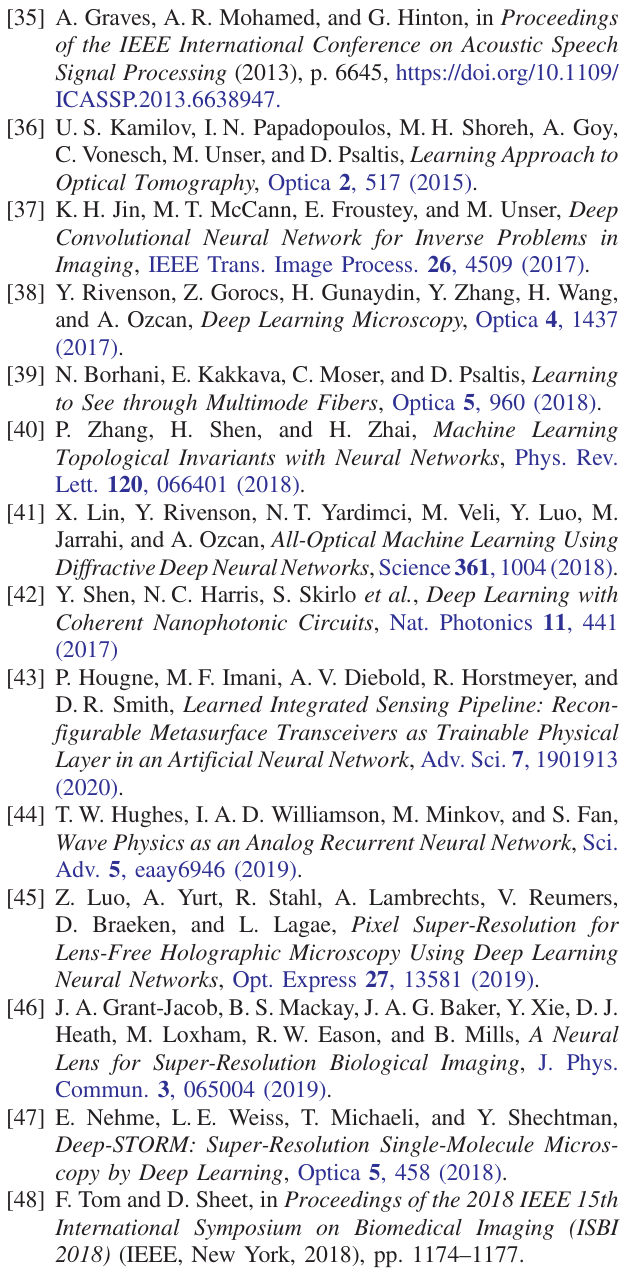
figurable Metasurface Transceivers as Trainable Physical Layer in an Artificial Neural Network , Adv. Sci. 7 ,